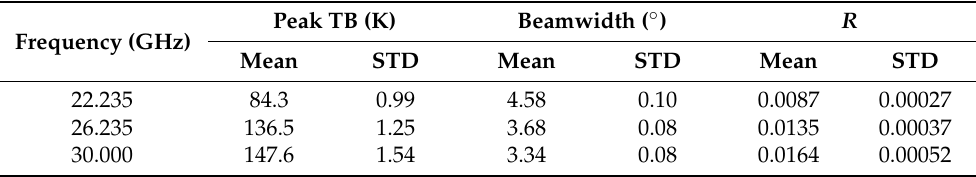
Figure 7. The daily variation of the maximum TB increment and beamwidth on 18 June 2020. The “Peak TB” is the maximum TB increment when the antenna beam points to the center of the sun. The ratio R is the sun filled-beam factor of the GMR antenna. All times were local time. ( a ) The maximum TB increment, ( b ) antenna beamwidth, and ( c ) the ratio R . Table 2. The statistical results of the beamwidth and the ratio of the solar solid angle to the antenna solid angle ( R ) on 18 June 2020 at the three frequencies. The “Peak TB” is the maximum solar TB increment when the antenna beam was pointed to the center of the sun. The “Mean” and “STD” are the mean value and standard deviation,